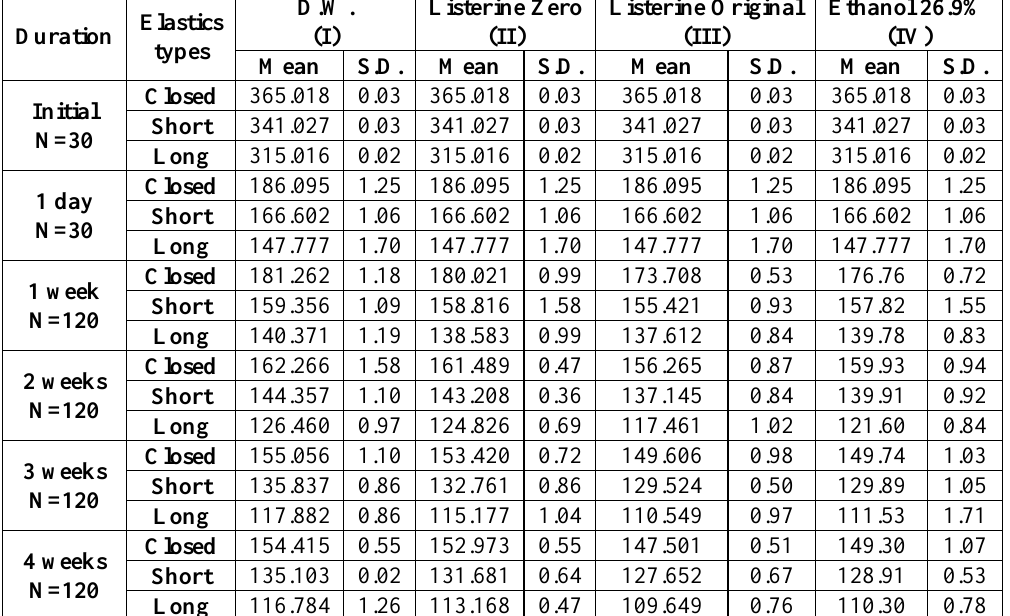
Table 1: Means and standard deviations of load values of different elastomeric chain types treated with different chemical solutions.